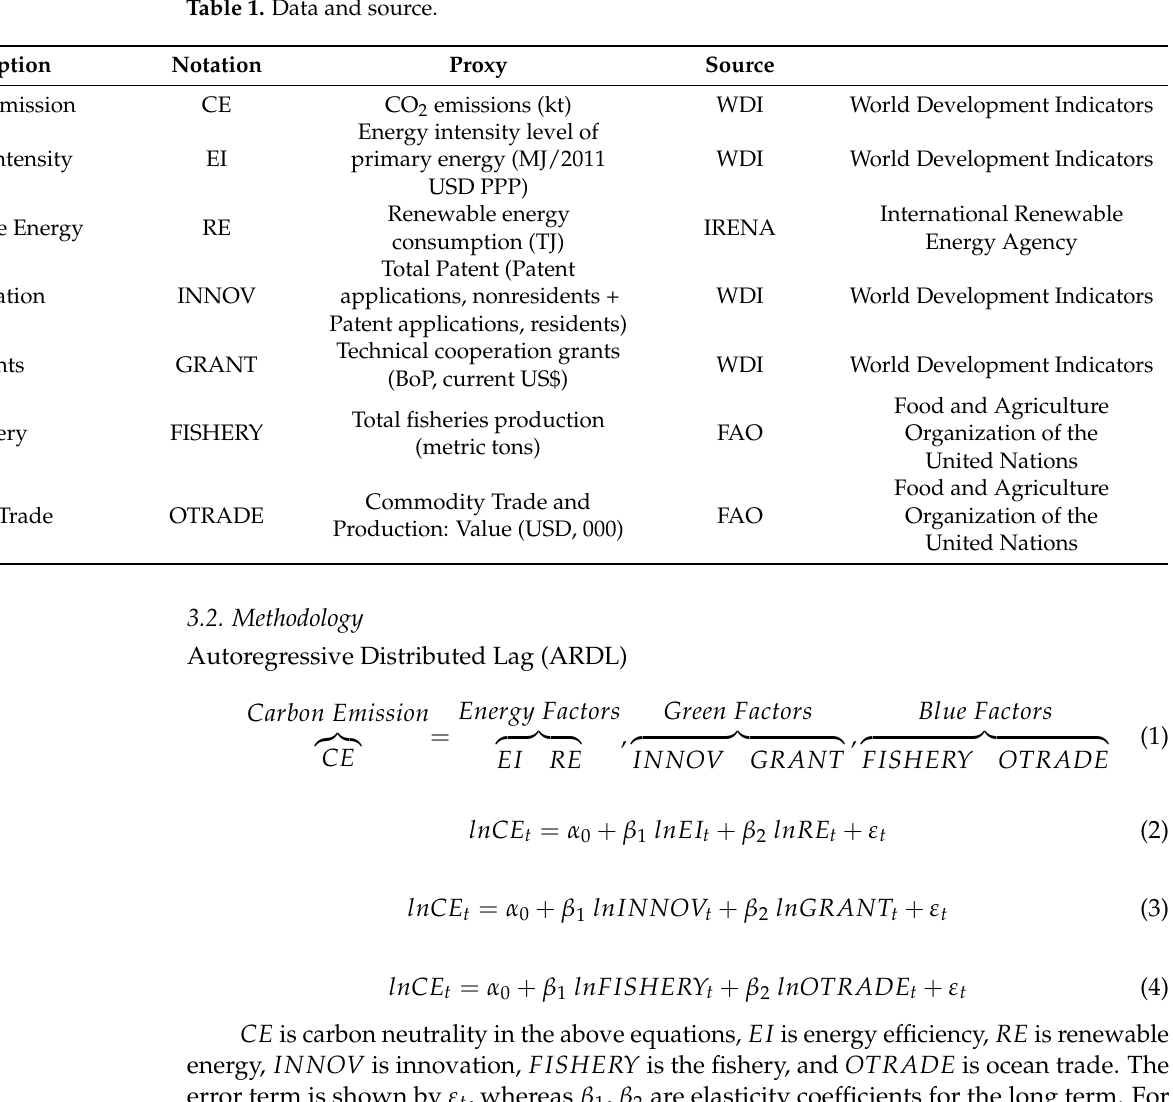
Table 1. Data and